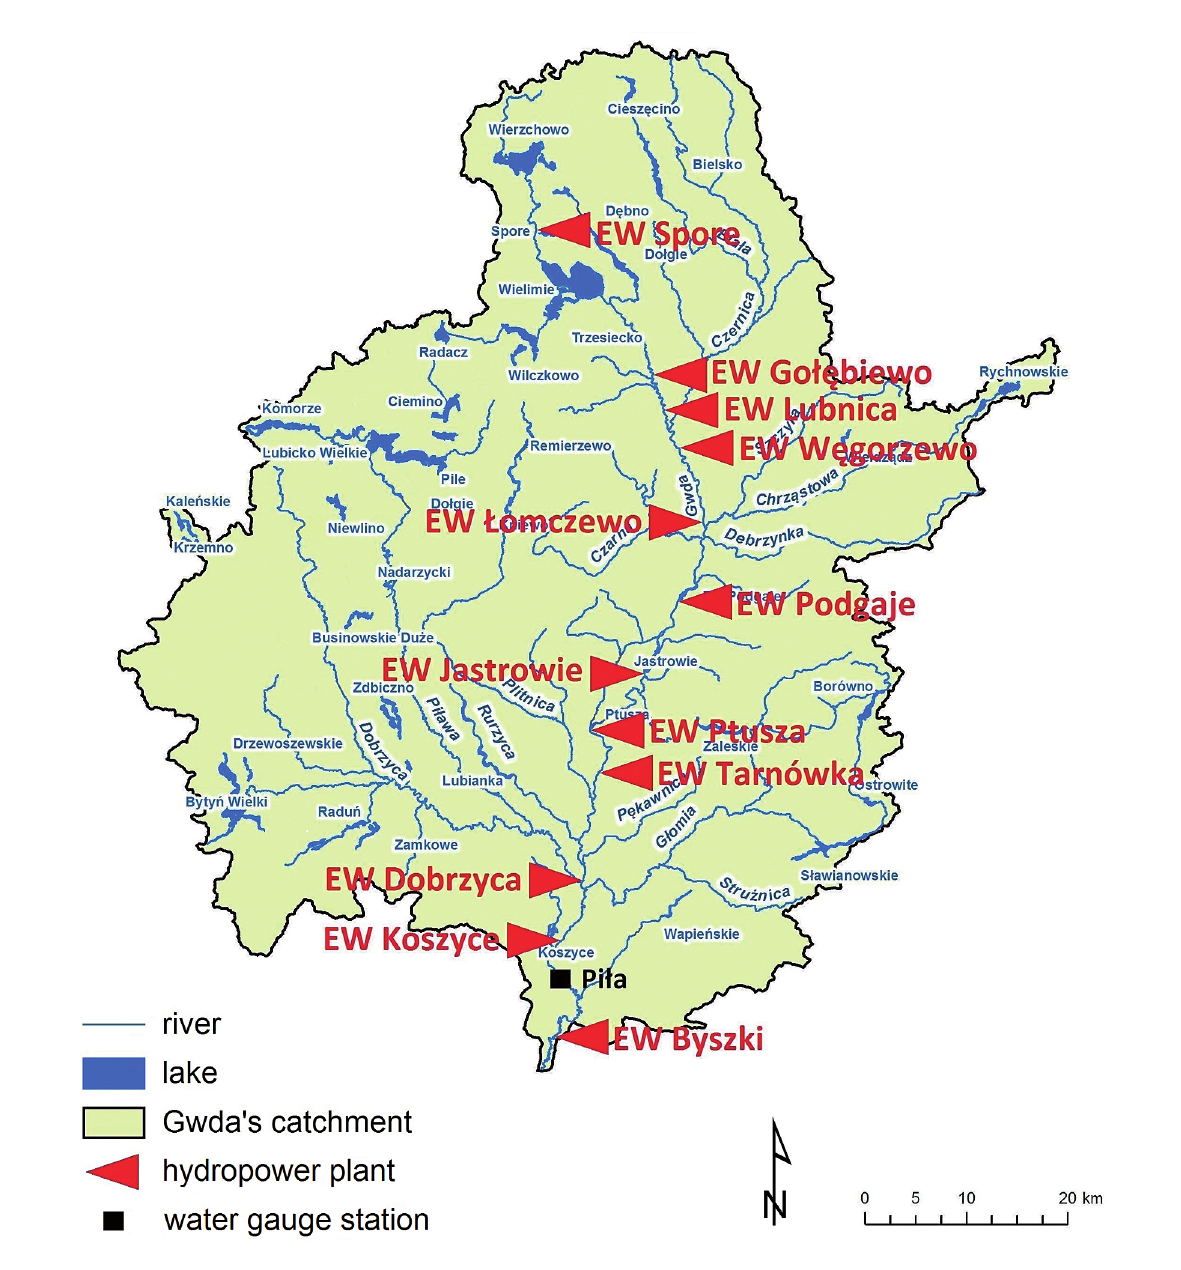
Fig. 1. Locations of hydropower plants on the Gwda